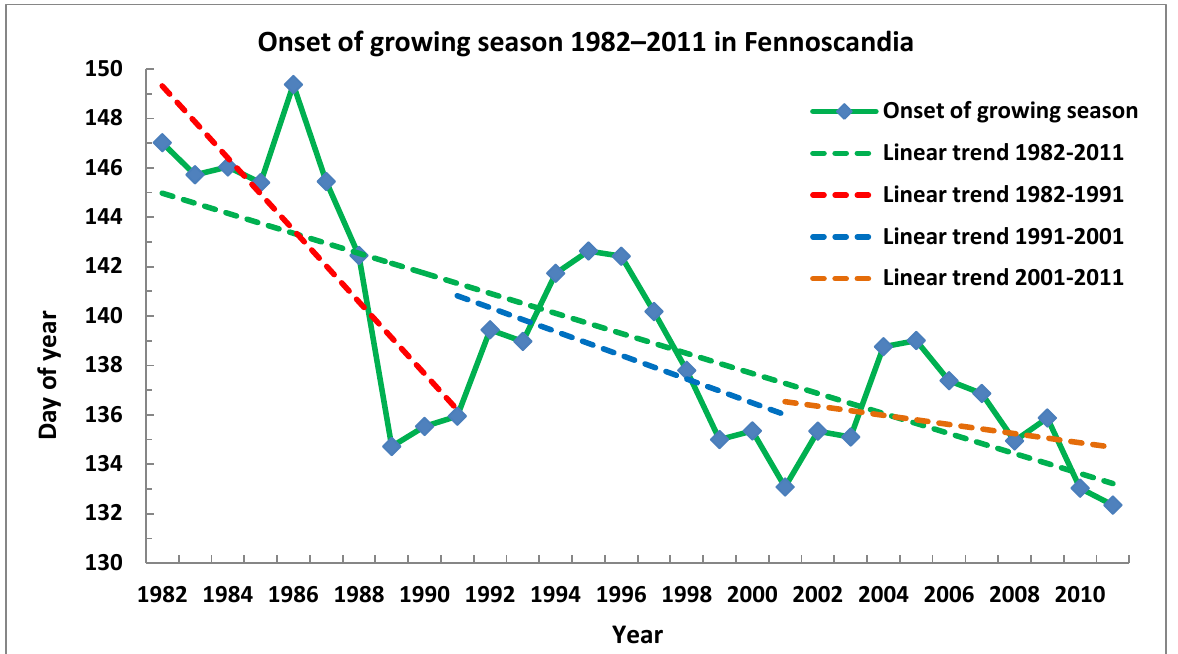
Figure 4. Trends in the start of the growing season for the whole study area for the whole period (1982–2011) and the 1982–1991, 1991–2001 and 2001–2011 periods. For the details of the trends, see the last row in Table